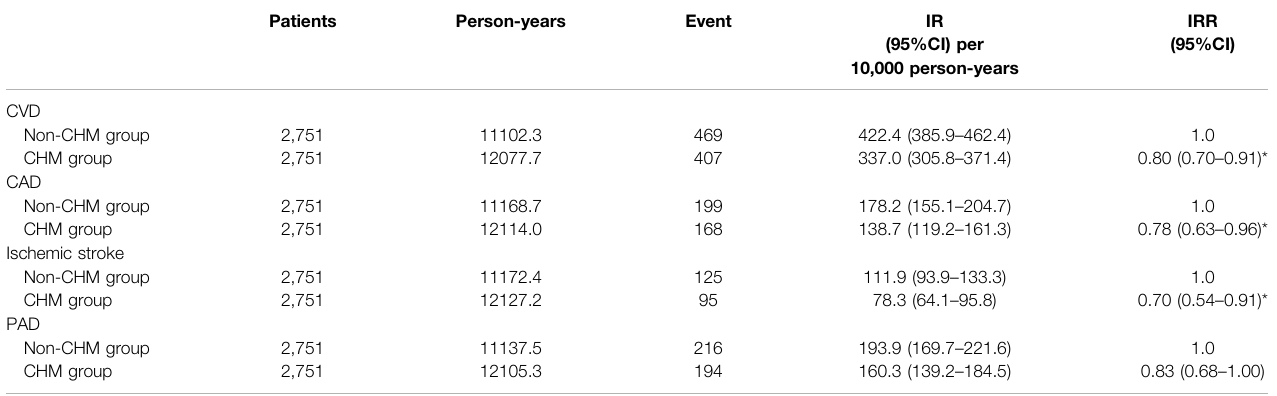
TABLE 2 | Incidence ratesand incidence rate ratios ofcardiovascular disease in systemic lupus erythematosus patients treated with and without Chinese herbal medicines.